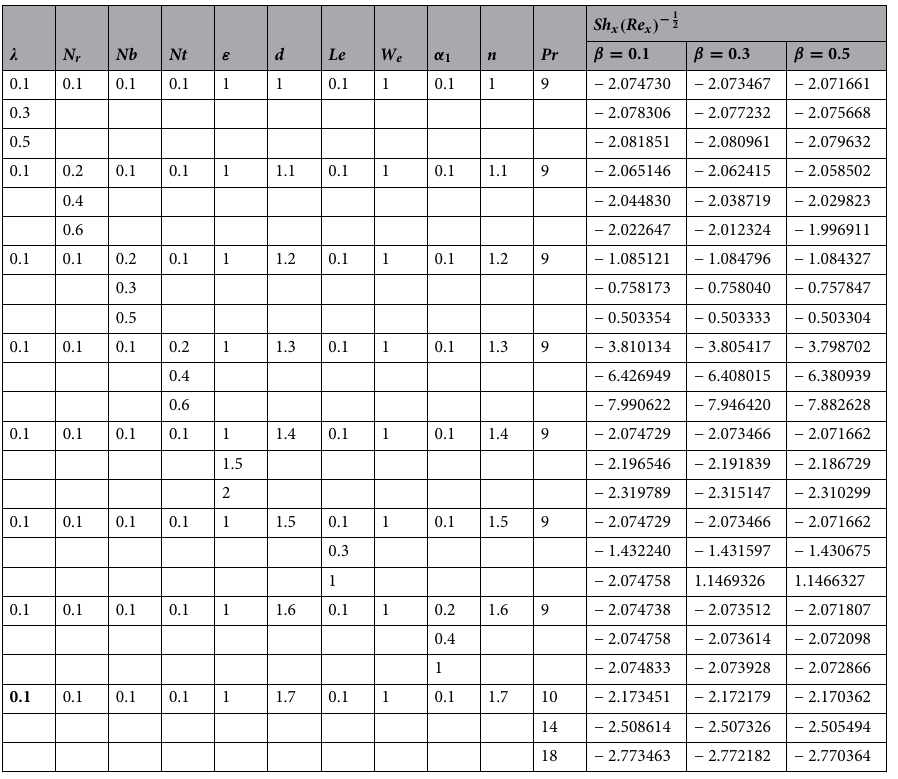
Table 3. Variation of Sh x ( Re x ) −